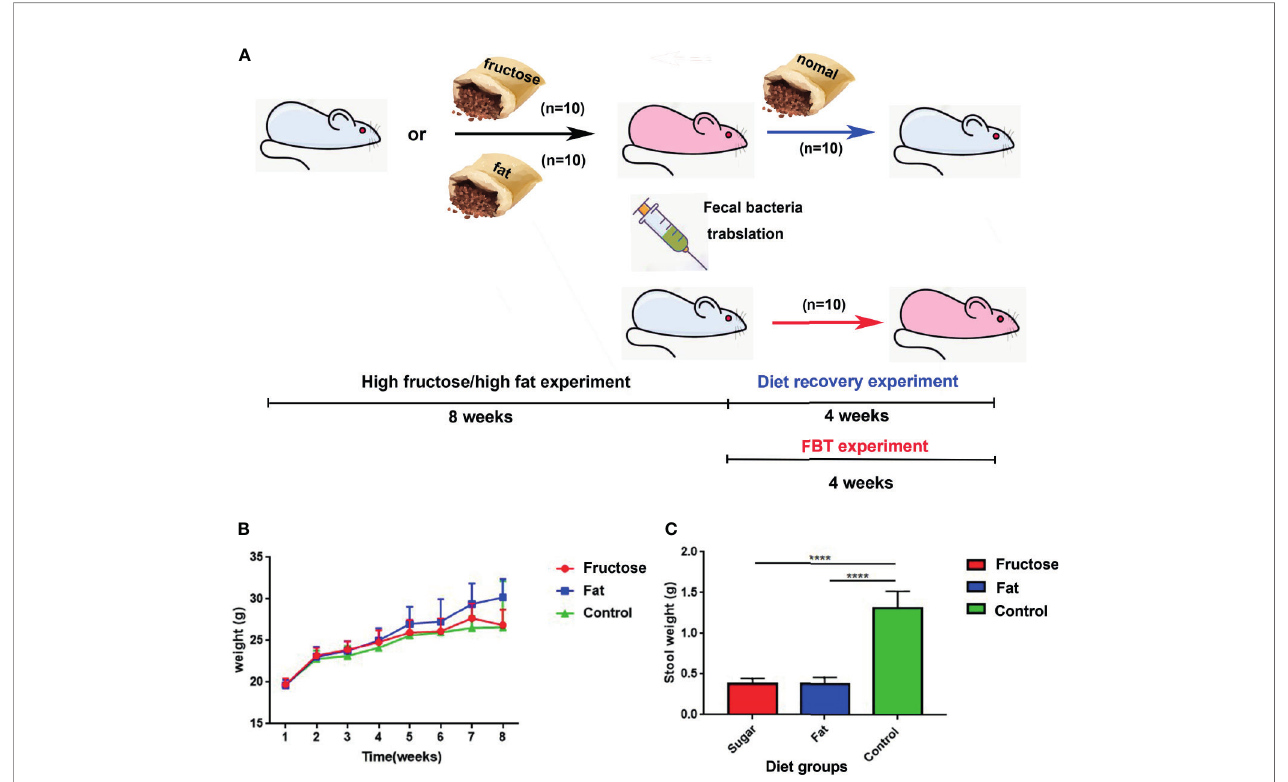
FIGURE 1 | The experimental design and animal experiment fl ow chart and changes in body weight and fecal volume of mice. Blue mice represent healthy mice, and pink mice represent in fl amed mice. The black arrow indicates the diet-induced in fl ammation experiment, the red arrow indicates the fecal bacteria transplantation experiment, and the blue arrow indicates the diet recovery experiment (A) . Changes in body weight of mice at 8 weeks (B) . 24 h fecal volume of mice in each group (C) . (****p <